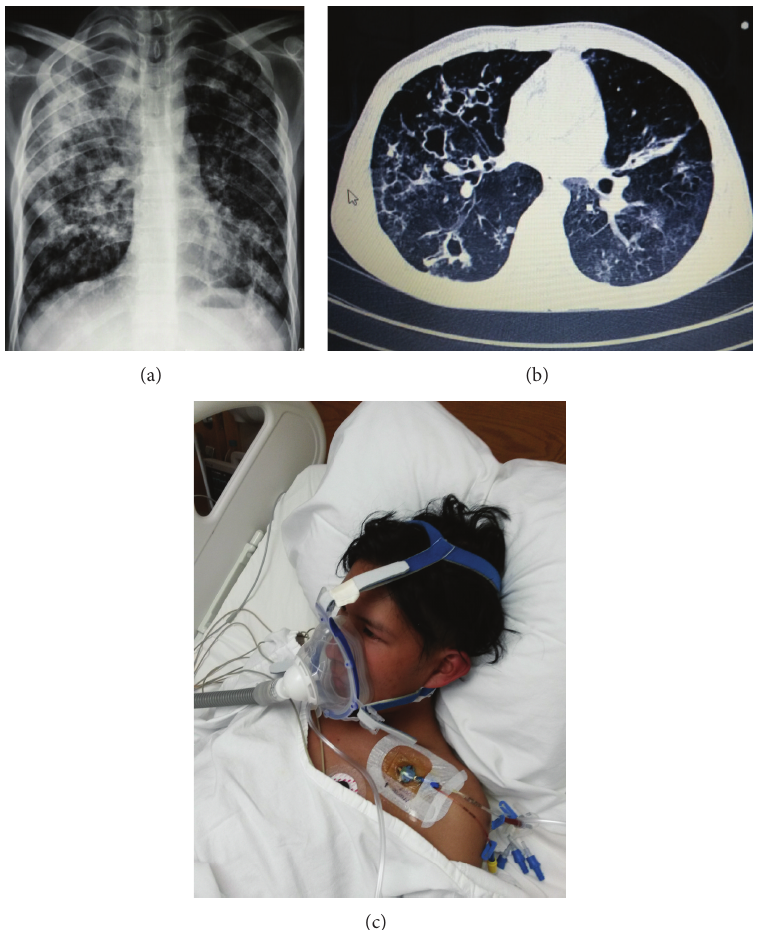
Figure 1: (a) Chest radiograph showing extensive multifocal consolidation and cavitation predominantly in the right upper lobe. (b) Computed tomography (CT) image scan obtained 5 weeks later shows the persistence of some caverns, nodules, and linear opacities but a significant improvement in areas of consolidation. (c) An oronasal mask was used to minimize air leakage and improve tolerance for noninvasive ventilation. Health personnelshould notoverlook theriskoftuberculosistransmissionassociated withshortdistances